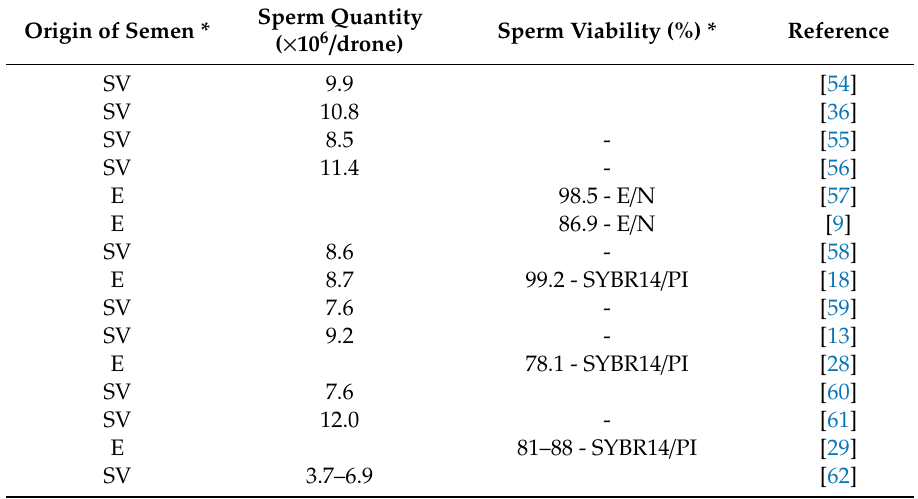
Table 1. Mean values, sperm recovery techniques and staining used for the semen quality traits more frequently assessed in honey bee